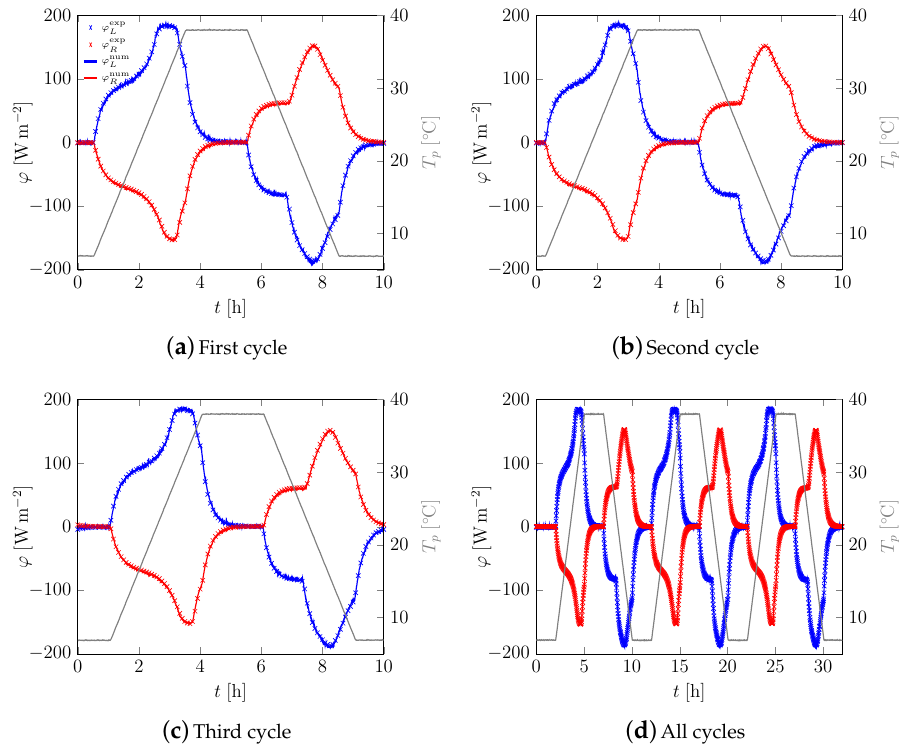
Figure A5. 19.2% w -PCM mortar: comparisons of the experimental fluxes with the numerical ones after identification for the 3h heating/cooling ramp